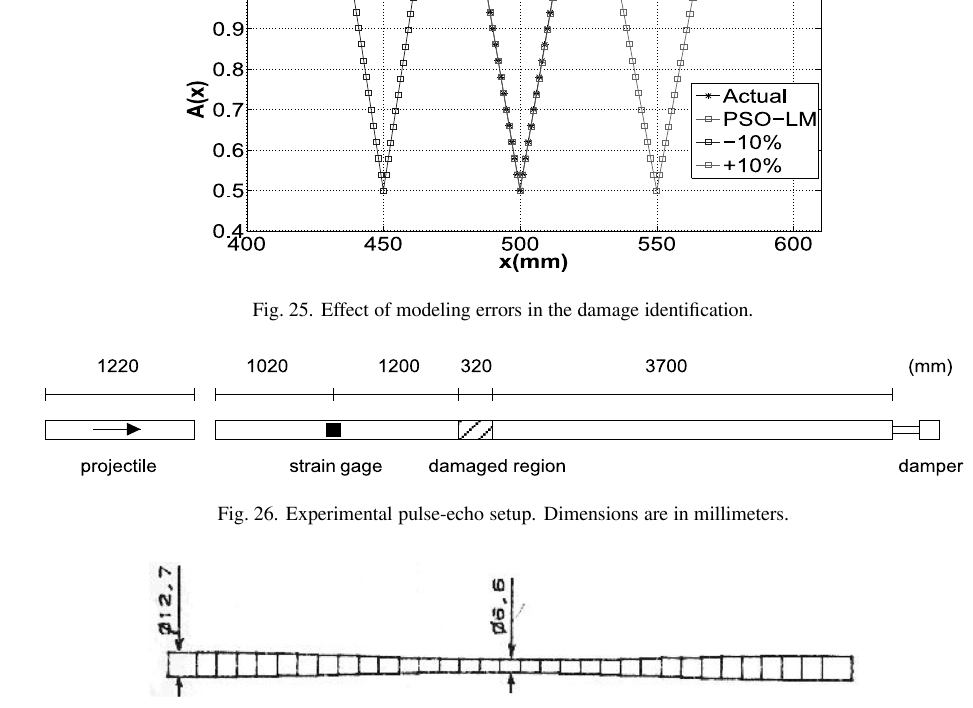
Fig. 27. Machined damage pro fi le. The maximum diameter is the nominal diameter of the bar, 12.7 mm, and the minimum diameter is 6.6